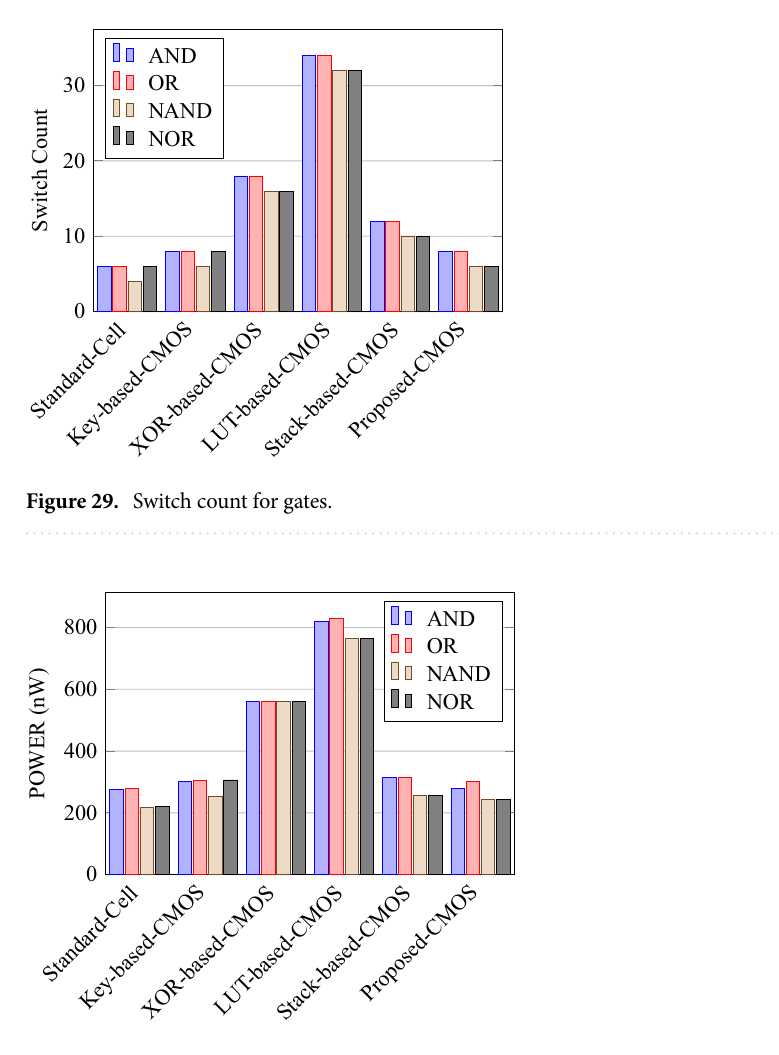
Figure 30. Total power consumed by each